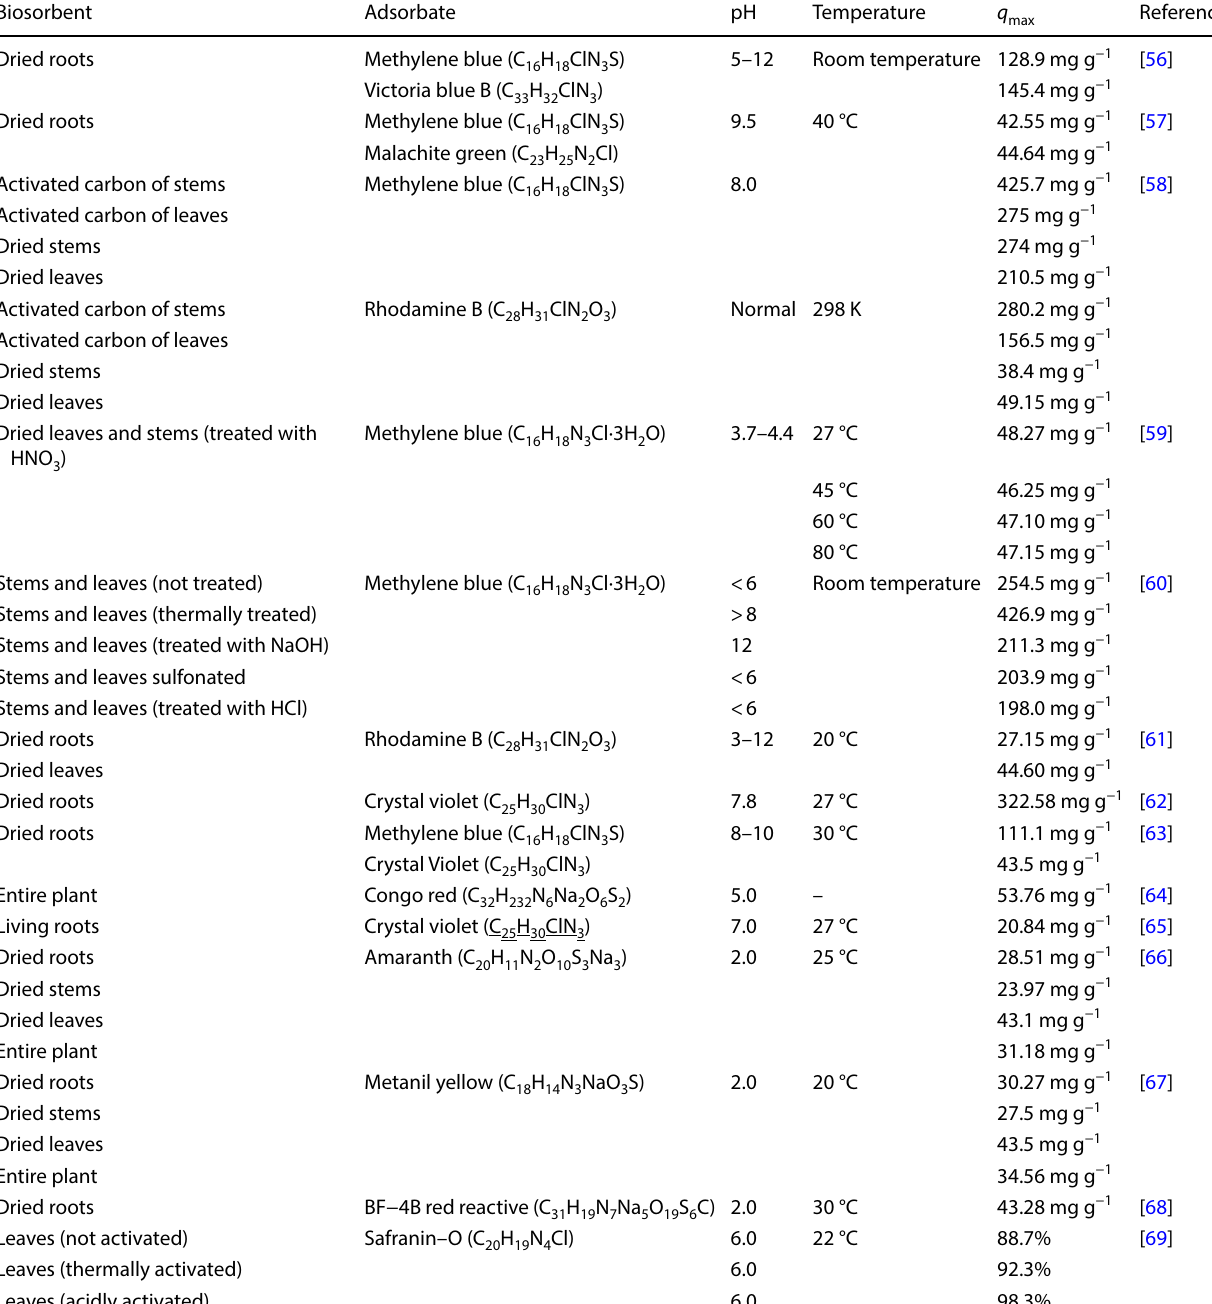
Table 5 The adsorption capacity of dyes by Eichhornia crassipes and its respective operational parameters